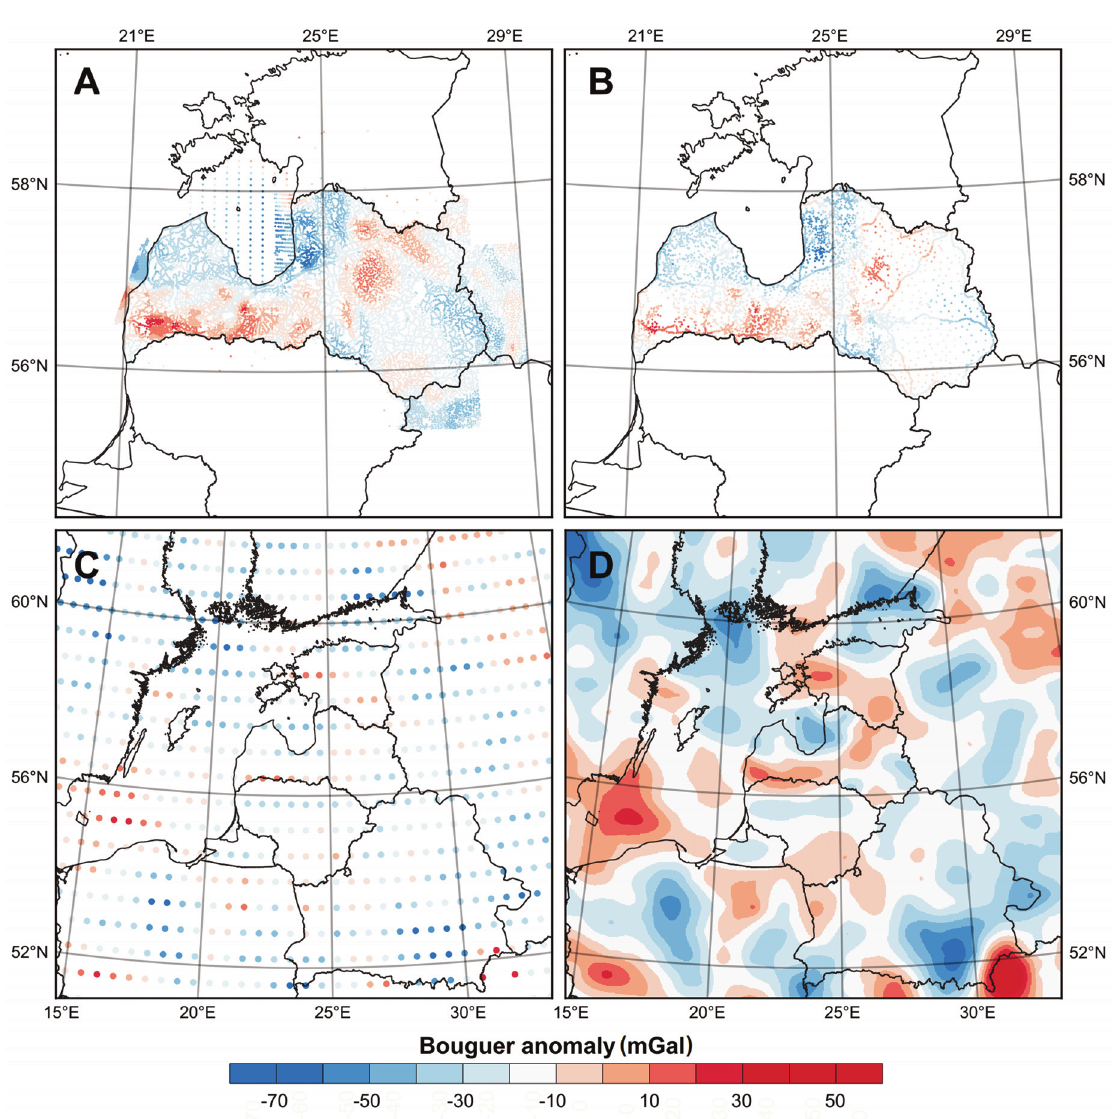
Fig. 2. Overview of gravity measurements in Latvia. A , dots represent calculated Bouguer anomaly from the geophysical mapping measurements from of the USSR­era (Kaminskis 2010); B , Bouguer anomaly from the gravity measurements by the Geodetic Survey of Latvia (Zandersons et al. 2018); C , Bouguer anomaly sampled from the EIGEN­6S4 satellite model (Förste et al. 2016); D , gridded and combined gravity